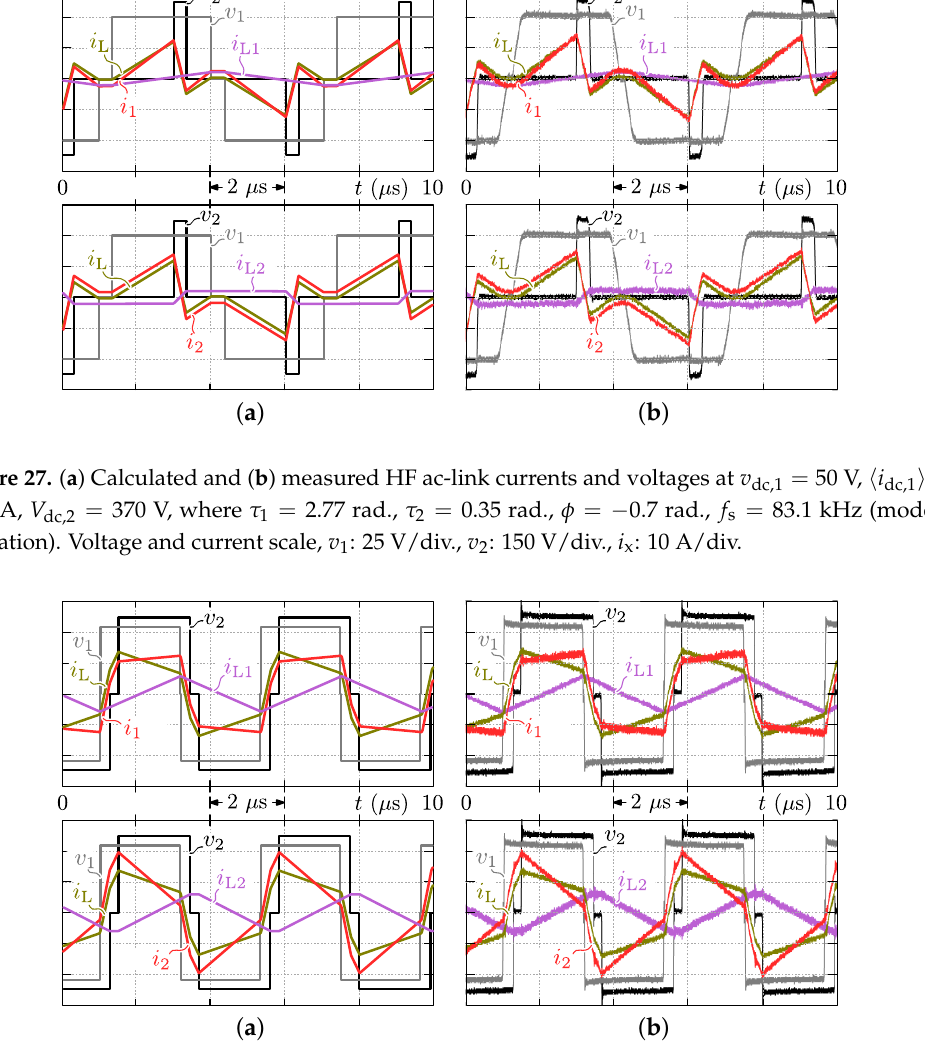
Figure 28. ( a ) Calculated and ( b ) measured HF ac-link currents and voltages at v dc,1 = 325.27 V, (cid:104) i (cid:105) = 18 A, V = 370 V, where τ = 3.11 rad., τ = 2.81 rad., φ = 0.4 rad., f s = 120 kHz (mode 2 2 1 dc,1 dc,2 operation). Voltage and current scale, v 1 : 150 V/div., v 2 : 150 V/div., i x : 20